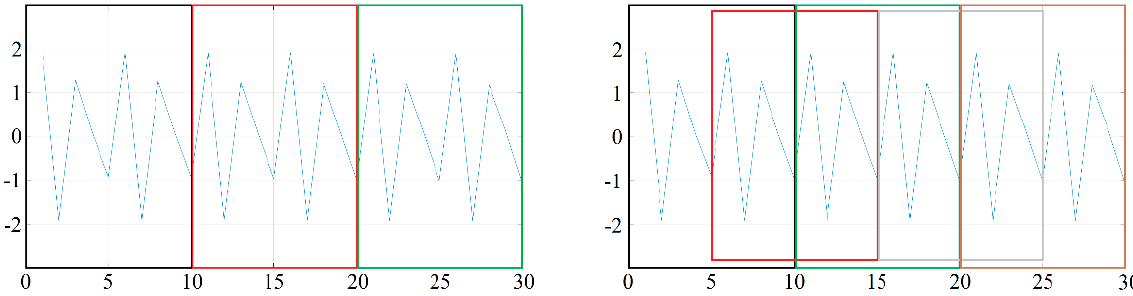
Figure 2. Segmentation methods. Non-overlapping segments on the left and 50% overlapping segments on the right.